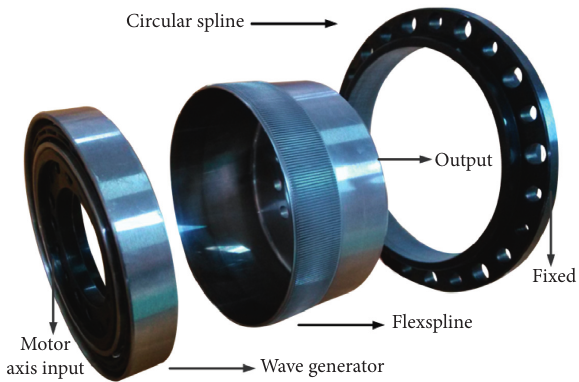
Figure 1: Exploded view of harmonic drive and